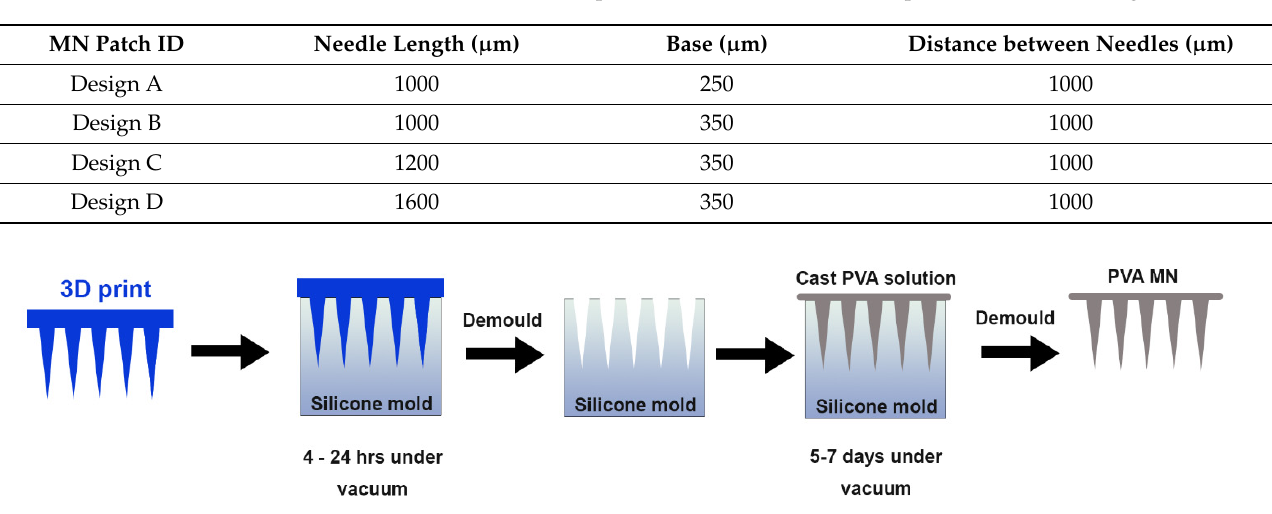
Table 1. Parameters of the 3D printed 5 × 5 microneedle cast prints used for molding.